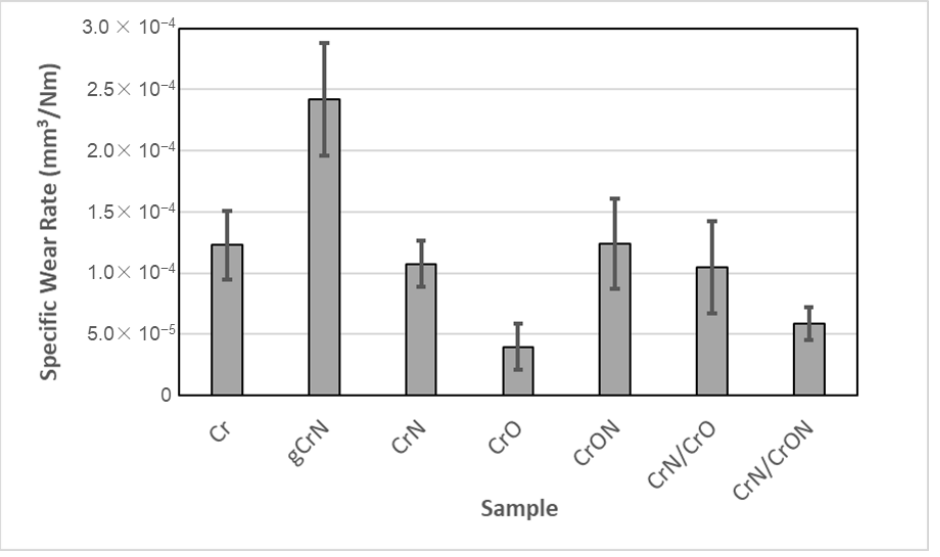
Figure 9. Specific wear rate of the coatings tested using dry sliding reciprocating tests.